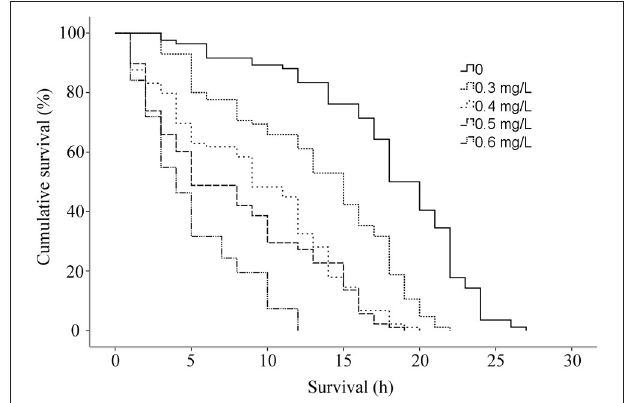
FIGURE 3 | Cumulative survival (%) in vitro of Gyrodactylus kobayashii at different concentrations of